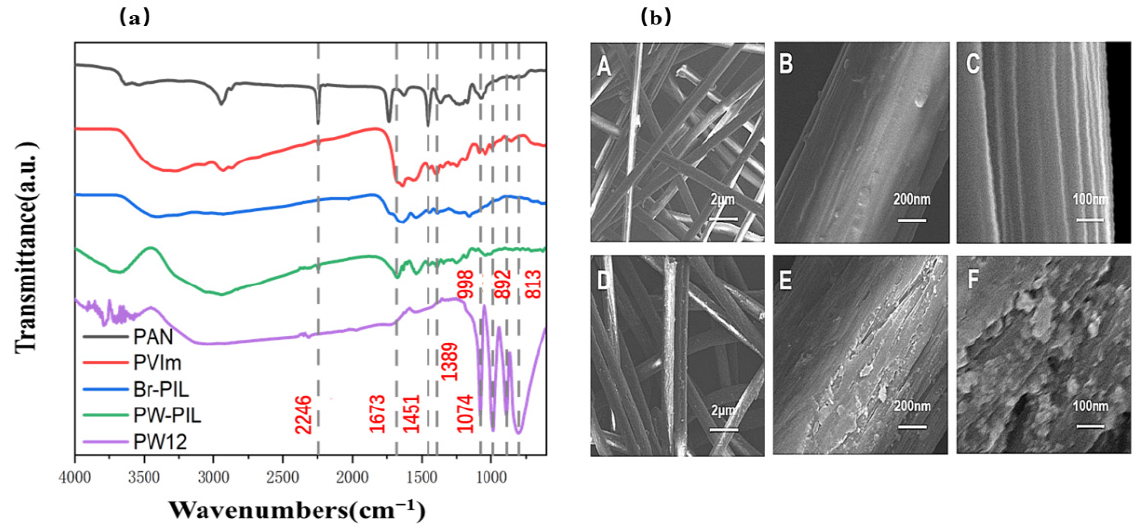
Figure 1. ( a ) FT-IR spectra of PAN, PVIm, Br-PIL, PW-PIL and PW12. ( b ) SEM images of PAN NF membrane ( A – C ) and PW-PIL NF membrane ( D – F ) with 2 µ m, 200 nm and 100 nm magnification.